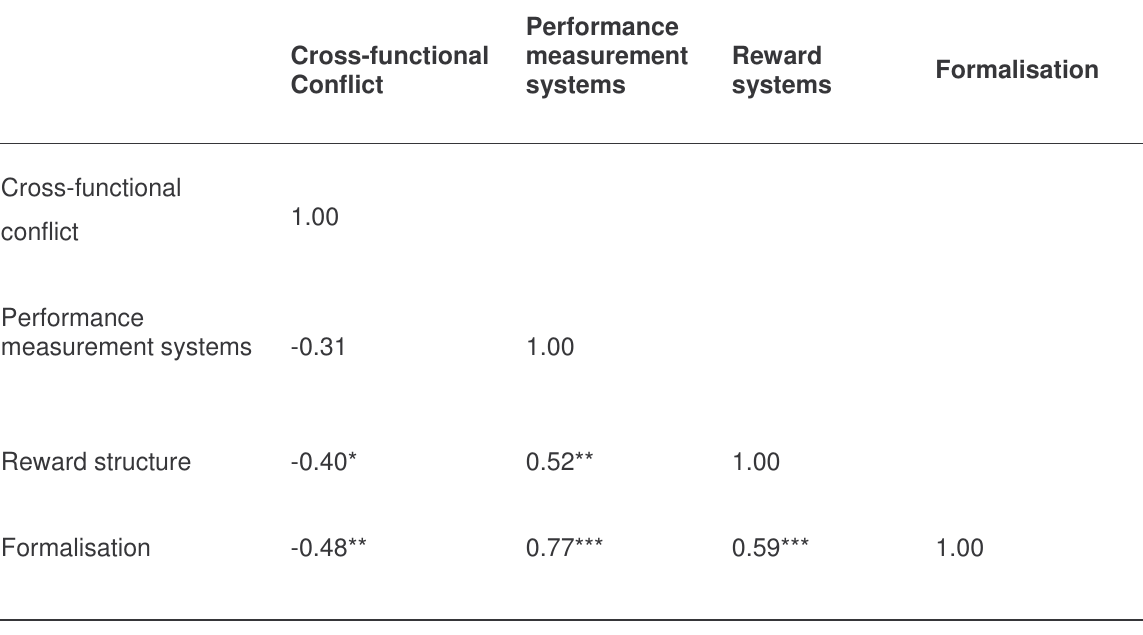
Table 2: Pearson correlation between focal